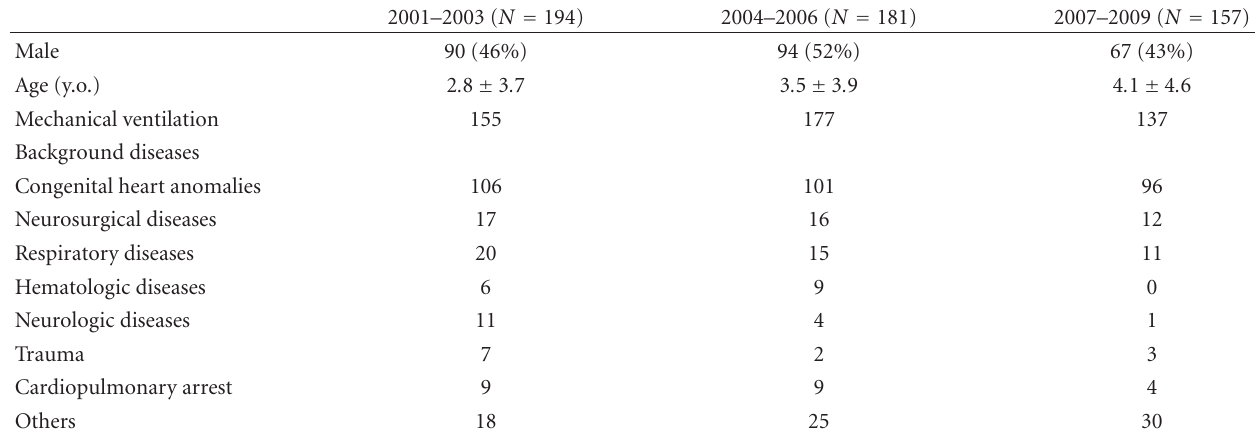
Table 1: Patient profile.